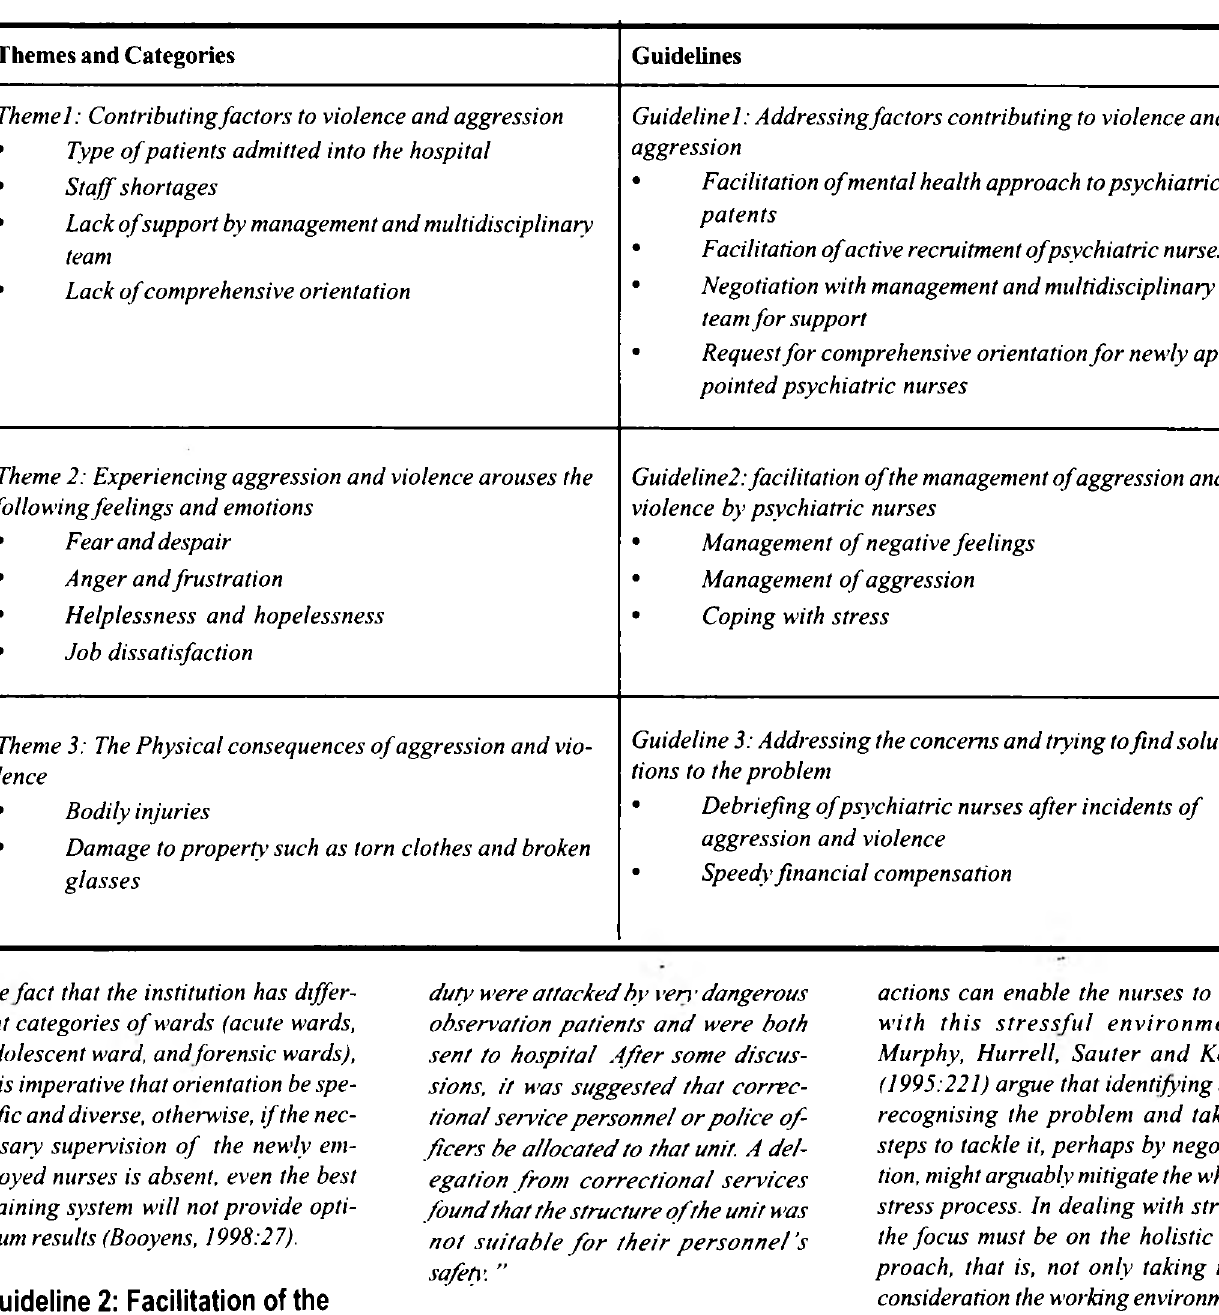
Table 2: challenges and possible corresponding solutions Themes and